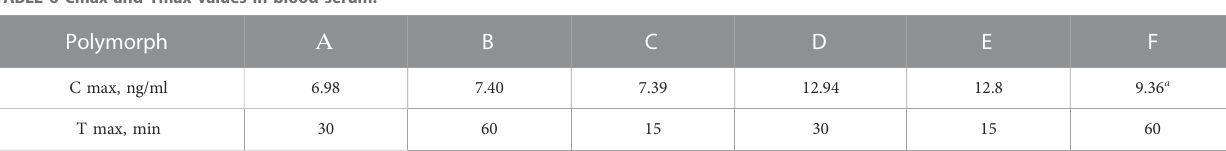
TABLE 6 Cmax and Tmax values in blood serum.